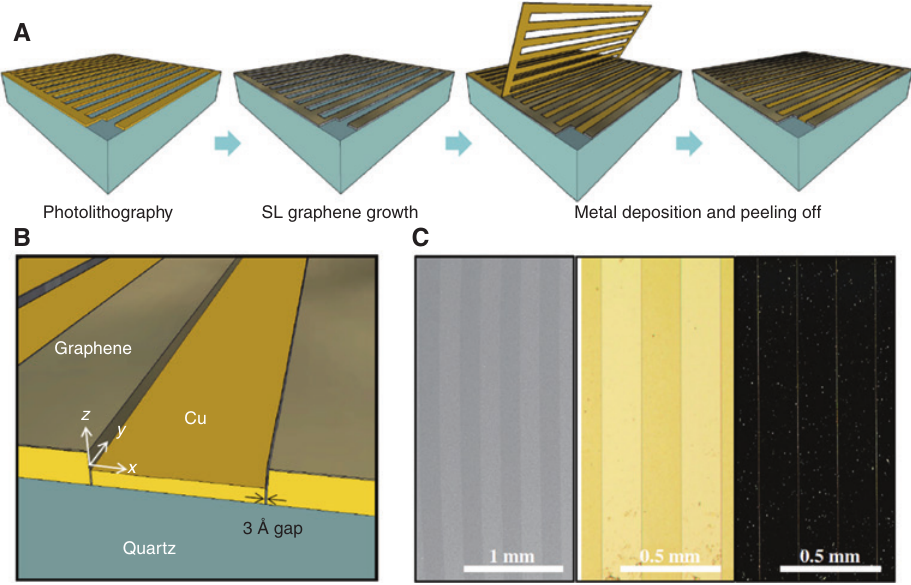
Figure 20: Fabrication of vertically oriented graphene spacer in Cu-single layer graphene (SLG)-Cu composite. (A) Schematic of the fabrication procedure. (B) Cross-sectional image of Cu-SLG-Cu array. (C) Top views of SEM (left), reflection type (center), and dark field scattering (right) optical microscope images. This figure is reproduced from Ref.